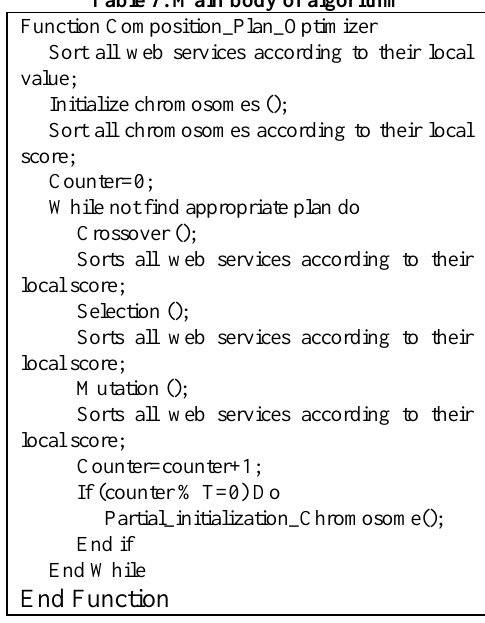
Figure 10. Crossover type